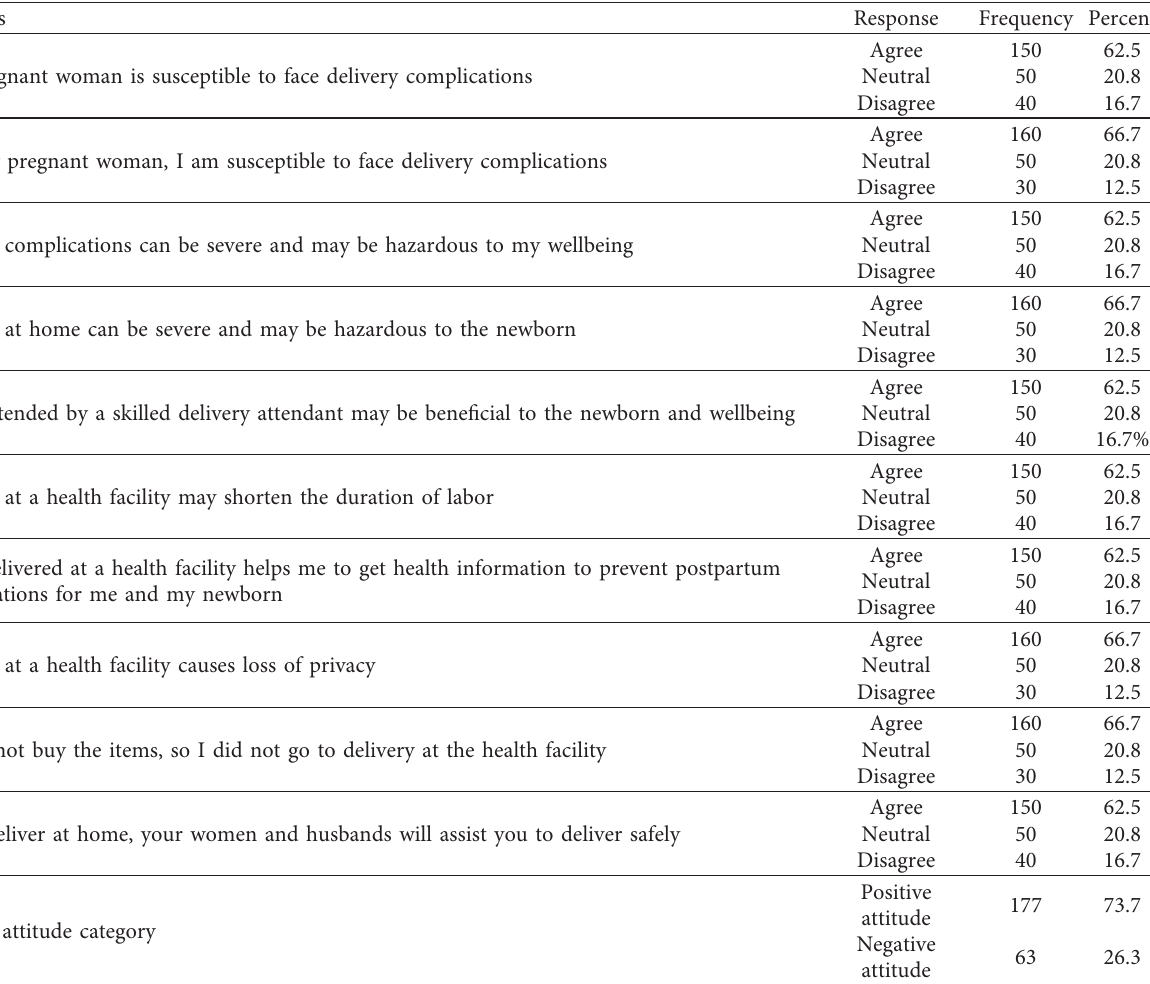
Table 3: Attitude toward institutional delivery among women who gave birth in the last one year at Serbo, Kersa Woreda, Southwest Ethiopia, July 2021.